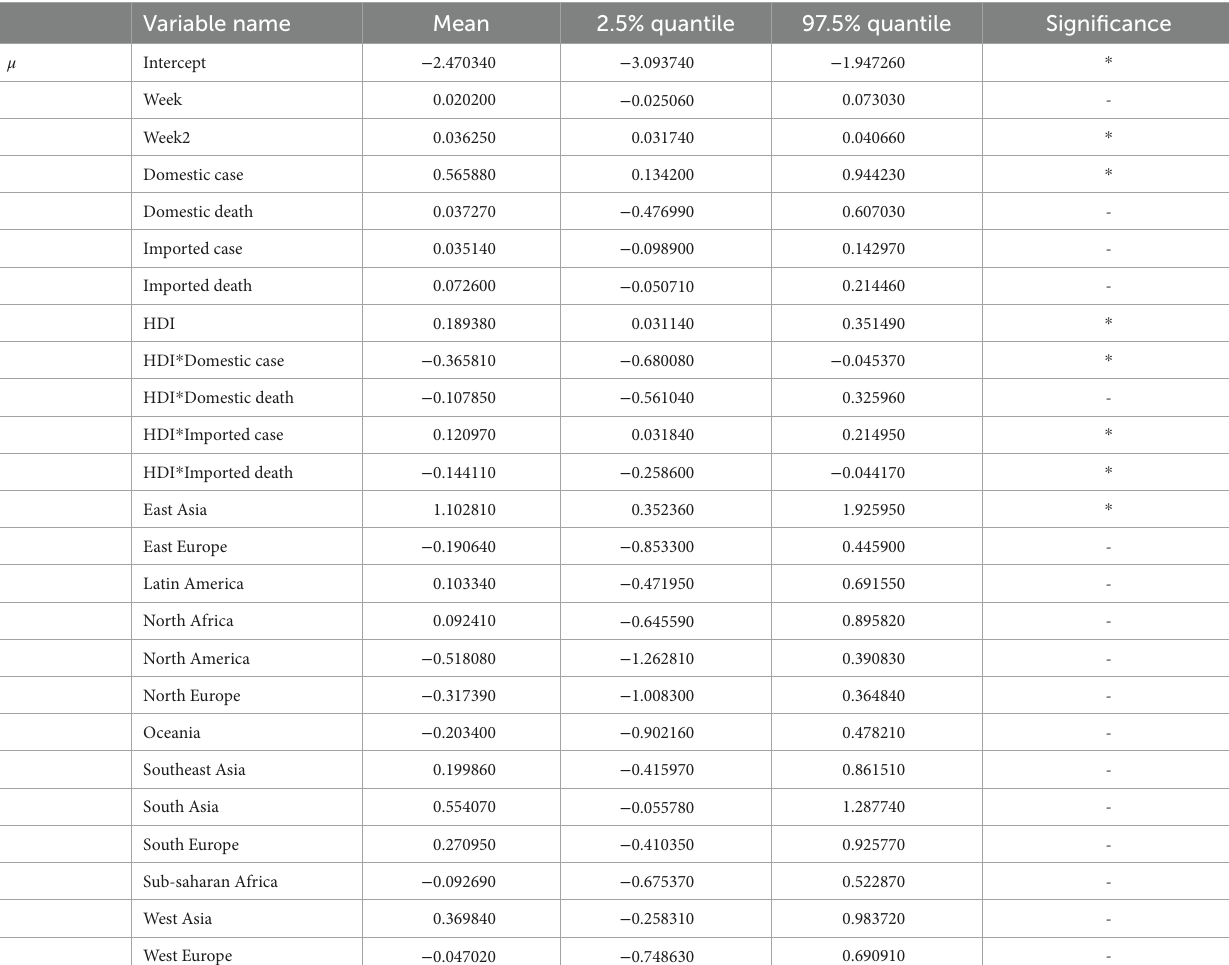
TABLE 2 ZOIB model